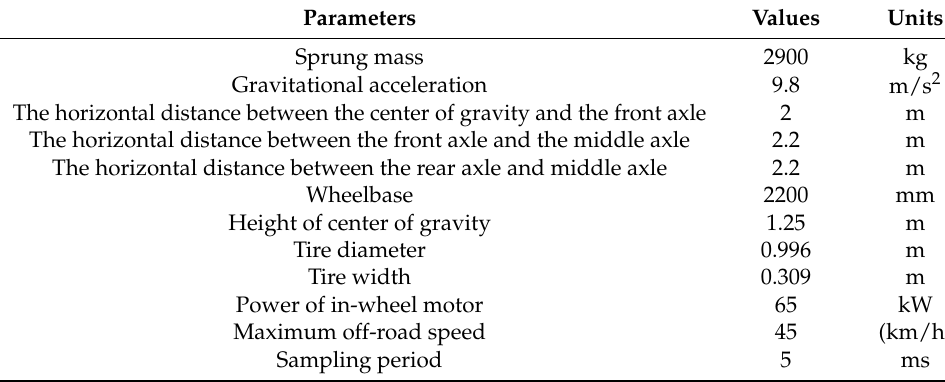
Table 1. The main parameters of 6WID/4WIS UGV.